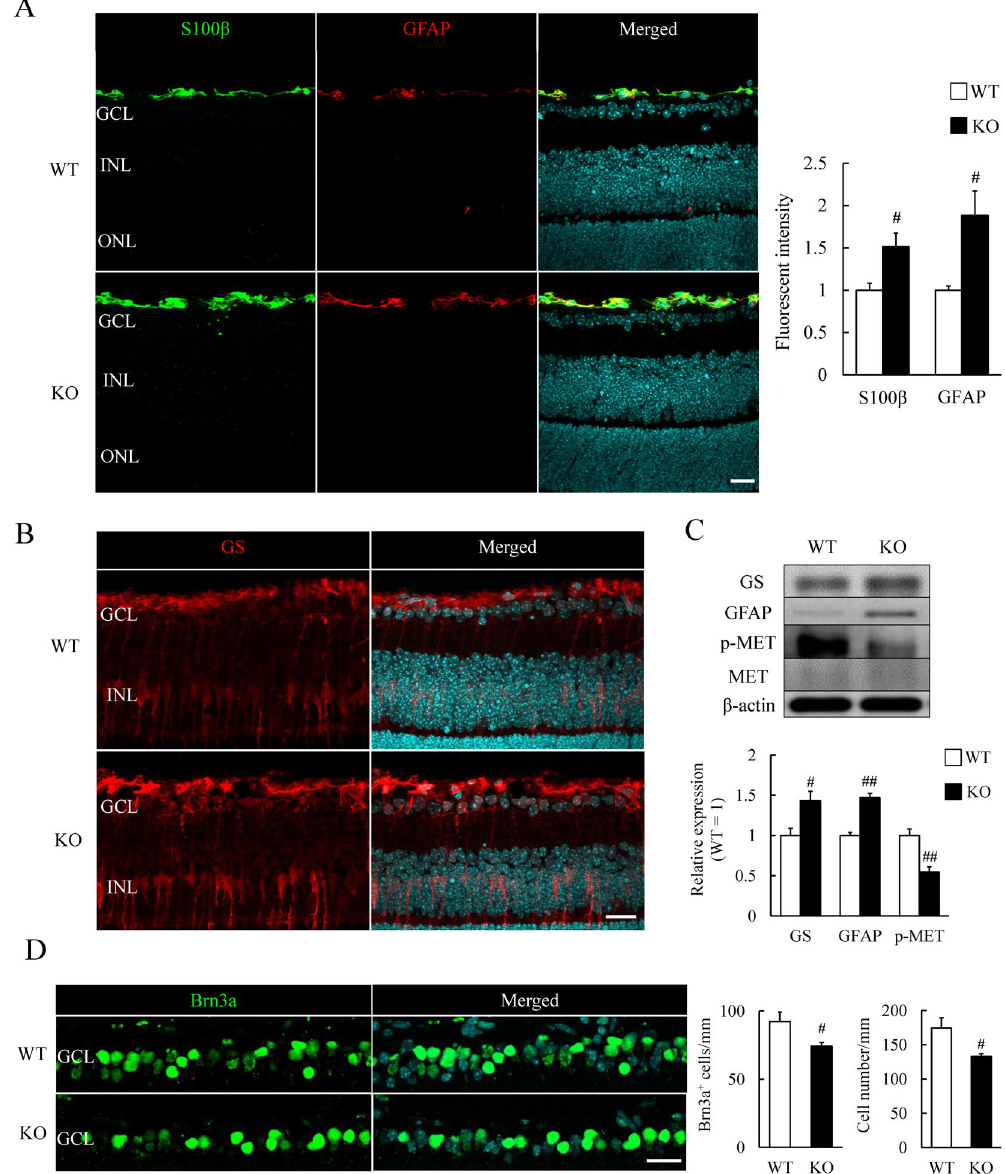
Figure 4. Retinal astrocyte activation and retinal ganglion cell loss in Grn − / − mice at P9. ( A ) S100 β + and GFAP + astrocytes (green and red) in P9 mice retina. Fluorescent intensity of S100 β and GFAP expression is increased in Grn − / − mice. Data are the means ± S.E.M. ( n = 5 or 6). # P < 0.05 vs. WT (Student’s t -test). ( B ) GS (red) stained astrocytes and Müller glia. Astrocytes activation is observed in Grn − / − mice at P9. ( C ) Typical band showed GS, GFAP, p-MET, MET, and β -actin. The quantitative data show the relative expression of GS and GFAP per β -actin and p-MET per MET. GS and GFAP expressions are increased in Grn − / − mice retina and the phosphorylation of MET is decreased in Grn − / − mice retina at P9. Data are the means ± S.E.M. ( n = 3 to 5). ## P < 0.01, # P < 0.05 vs. WT (Student’s t -test). ( D ) Brn3a staining (green) shows the RGCs. The nuclei are stained cyan by Hoechst 33342. The quantitative data show that the number of Brn3a + cells and the cell numbers in the GCL were decreased in Grn − / − mice at P9. Data are the means ± S.E.M. ( n = 5). # P < 0.05 vs. WT (Student’s t -test). WT: Wild-type; KO: Knock-out. Scale bar = 20 μ m. The cropped blots are used in this Figure and the full-length blots are presented in Supplementary Fig.